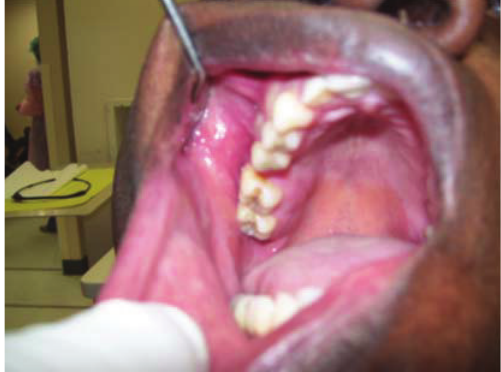
Figure 7: Case 5. Slight swelling of the maxilla.